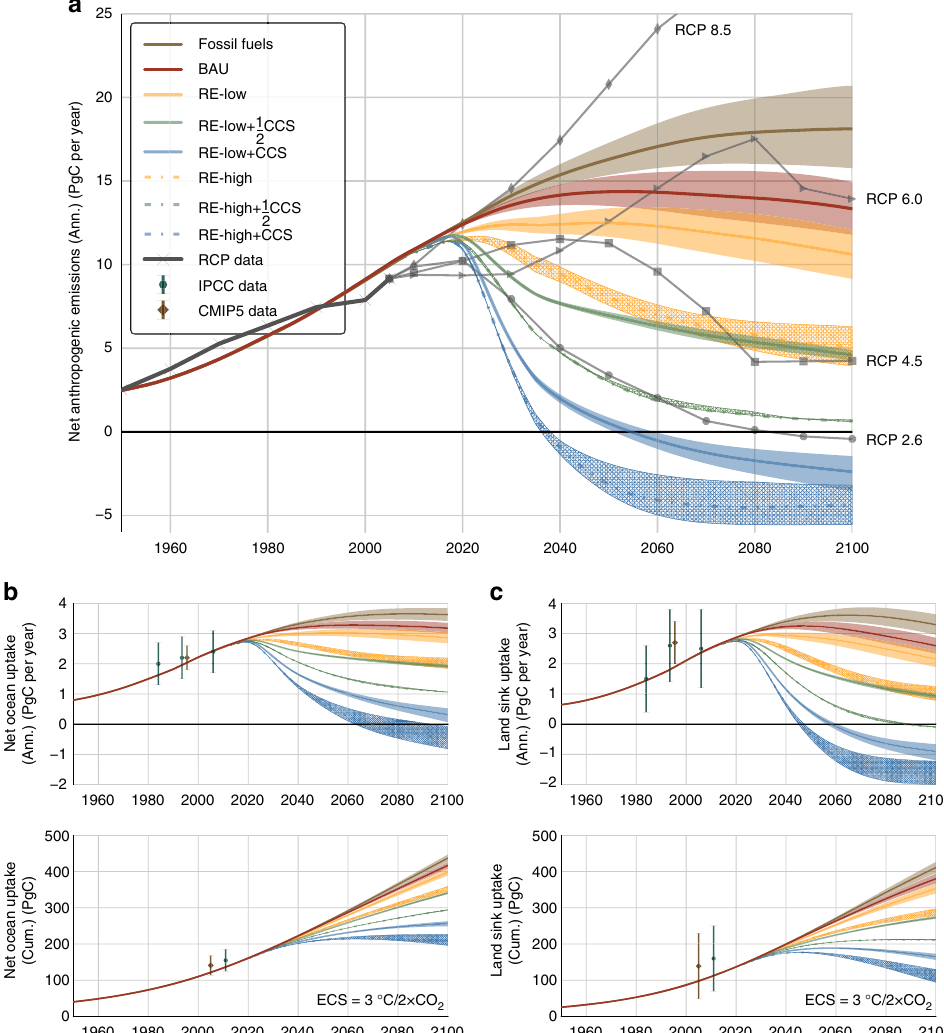
Figure 5 | Global carbon fluxes. ( a ) Annual net anthropogenic emissions (PgC per year). RCP data (thick grey line) and projections (thin grey series) shown for comparison; annual and cumulative carbon flux from the atmosphere to the ( b ) oceans and ( c ) land sink (biosphere & pedosphere). Historical data with associated errors ( cf. equation (12)): IPCC AR5 (green bars) 3 and CMIP5 (brown bars) 5